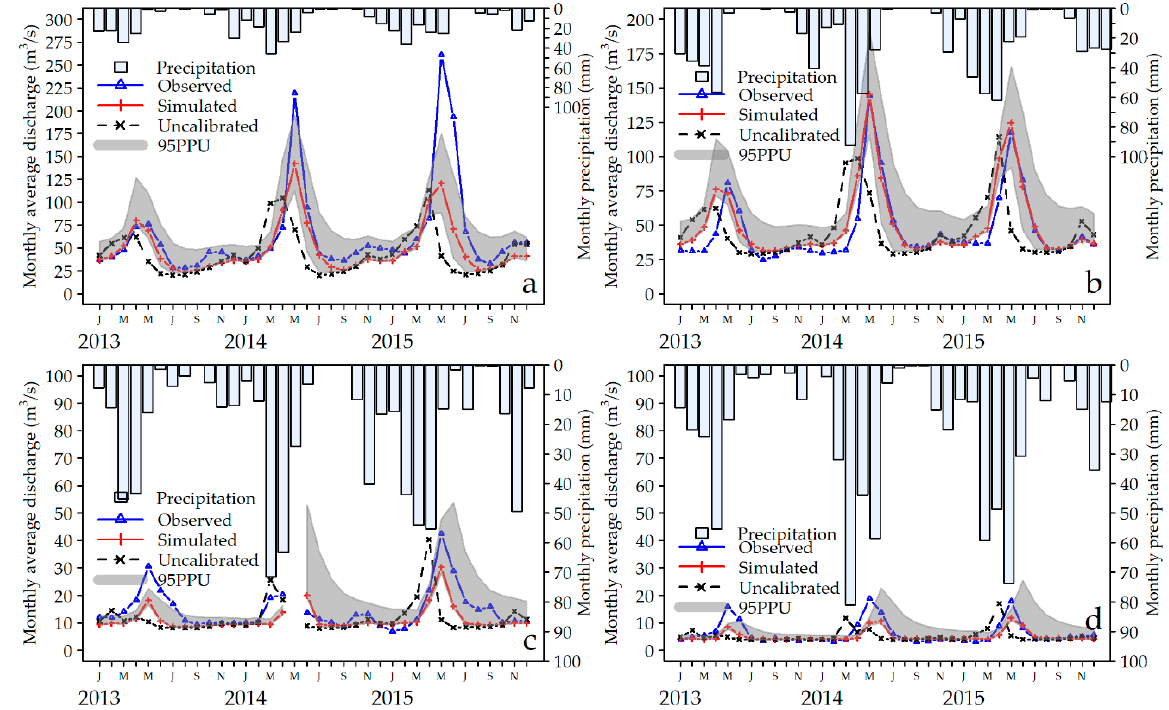
Figure 7. Comparisons among the observed and simulated monthly average discharges before and after calibration in addition to the 95 PPU uncertainty range from the calibration and monthly precipitation from 2013 to 2015. ( a ) subbasin 7, ( b ) subbasin 10, ( c ) subbasin 28, and ( d ) subbasin 30.